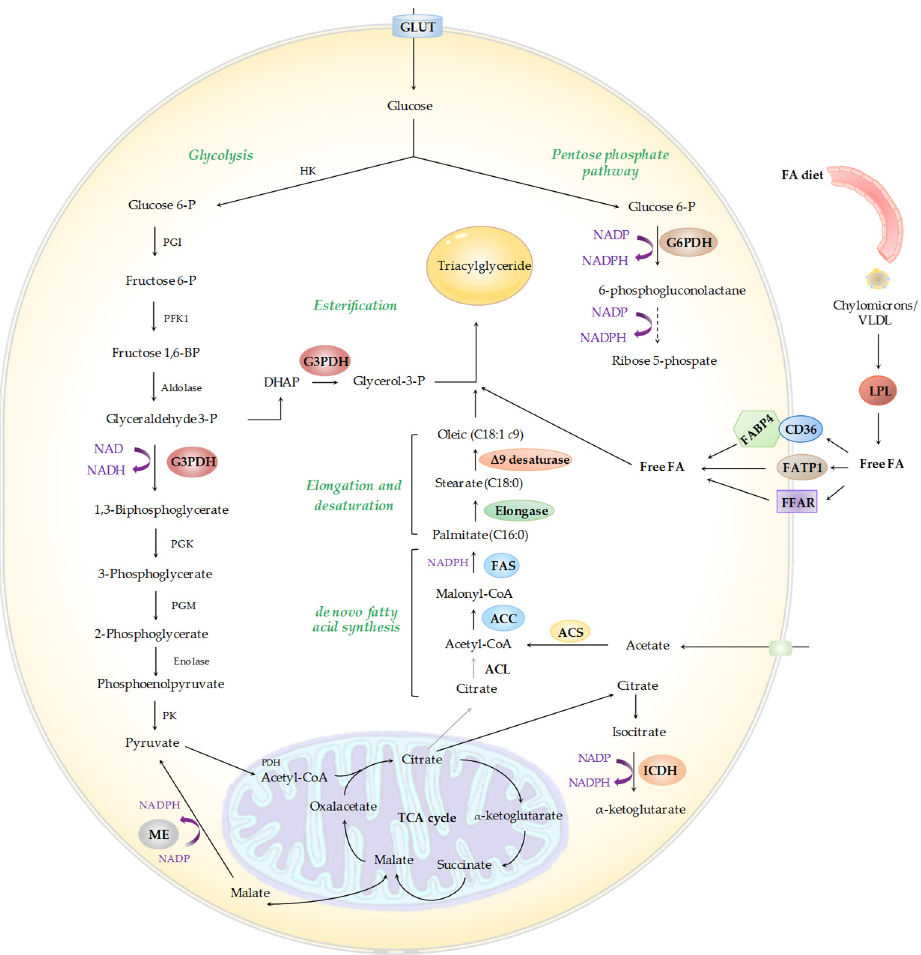
Figure 2. Schematic representation of the metabolic pathways involved in the synthesis of fatty acids and